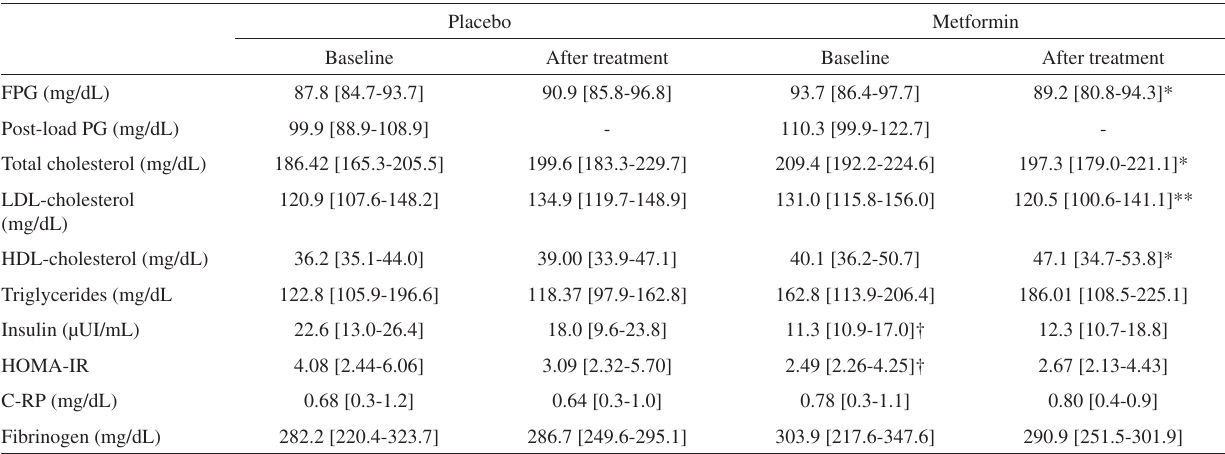
Table 2 - Laboratory data for both groups at baseline and after treatment